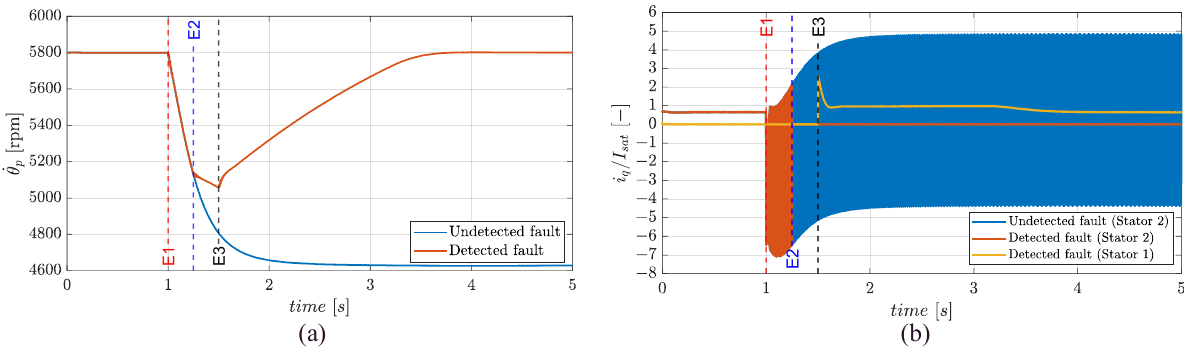
Figure 13. FEPS response in cruise with phase-to-ground fault on stator 2 (E1, E2 and E3 defined in Section 3.1): propeller speed ( a ), quadrature current ( b ), with I sat = 46 Arms.